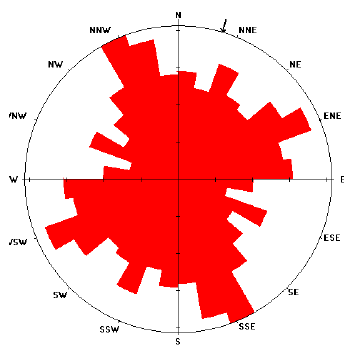
Figure 14. Rose diagram showing distribution of lineaments in the Basin by